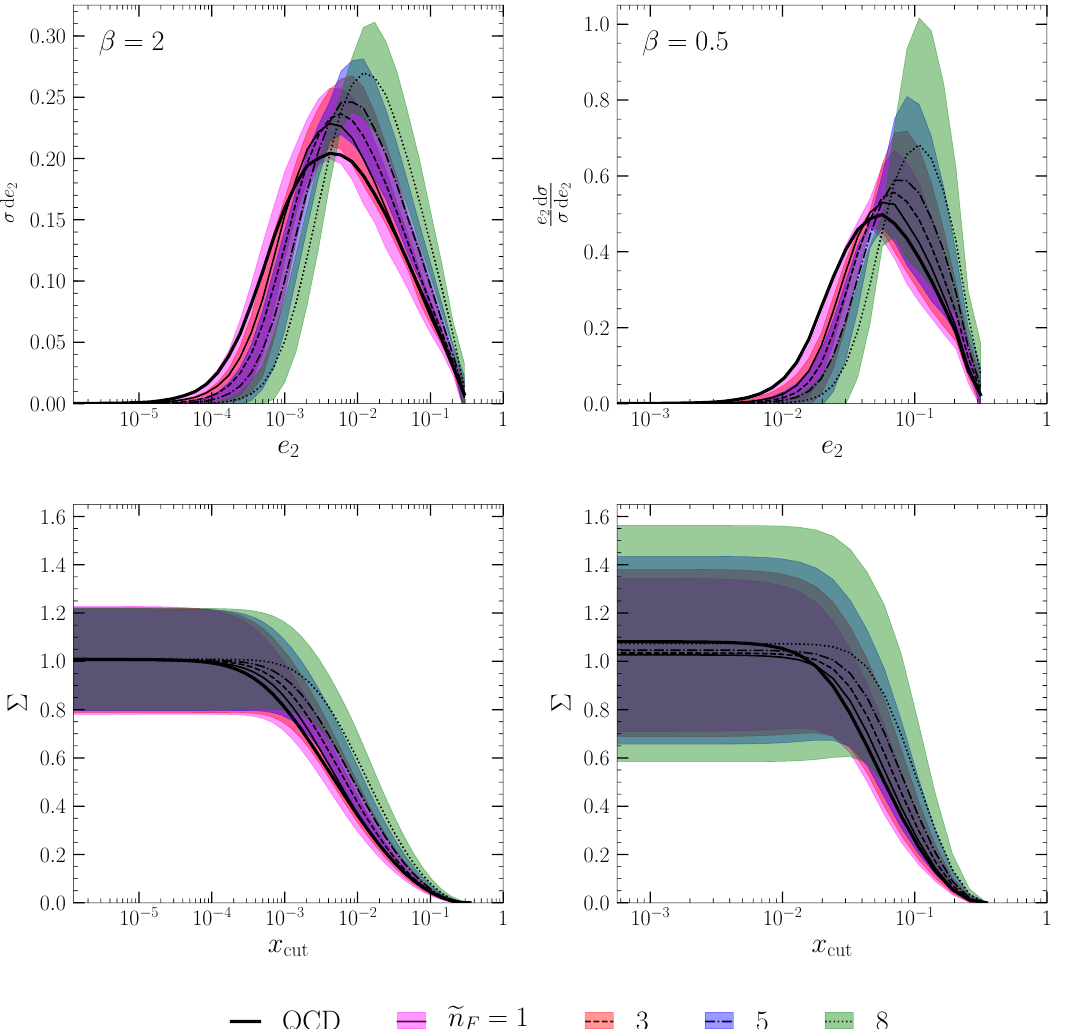
Figure 7 . The behavior of e 2 as the number of dark quark flavors n F is varied, for p T = 1 TeV e jets. See the legend for values of n F ; all other values are given in table 1. We show the normalized e e 2 distributions [top], where the central value of the envelope is marked with the black lines, while the shaded region denotes the envelope. The peak moves to higher values of e 2 as e N C is increased. The cumulant distributions (cid:6) as a function of x cut are also provided [bottom], where again the lines denote the central values and the shaded bands are the integrated envelopes, see eq. (2.9). We show both results for two choices of the angular dependence: (cid:12) = 2 [left] and (cid:12) = 0 : 5 [right].